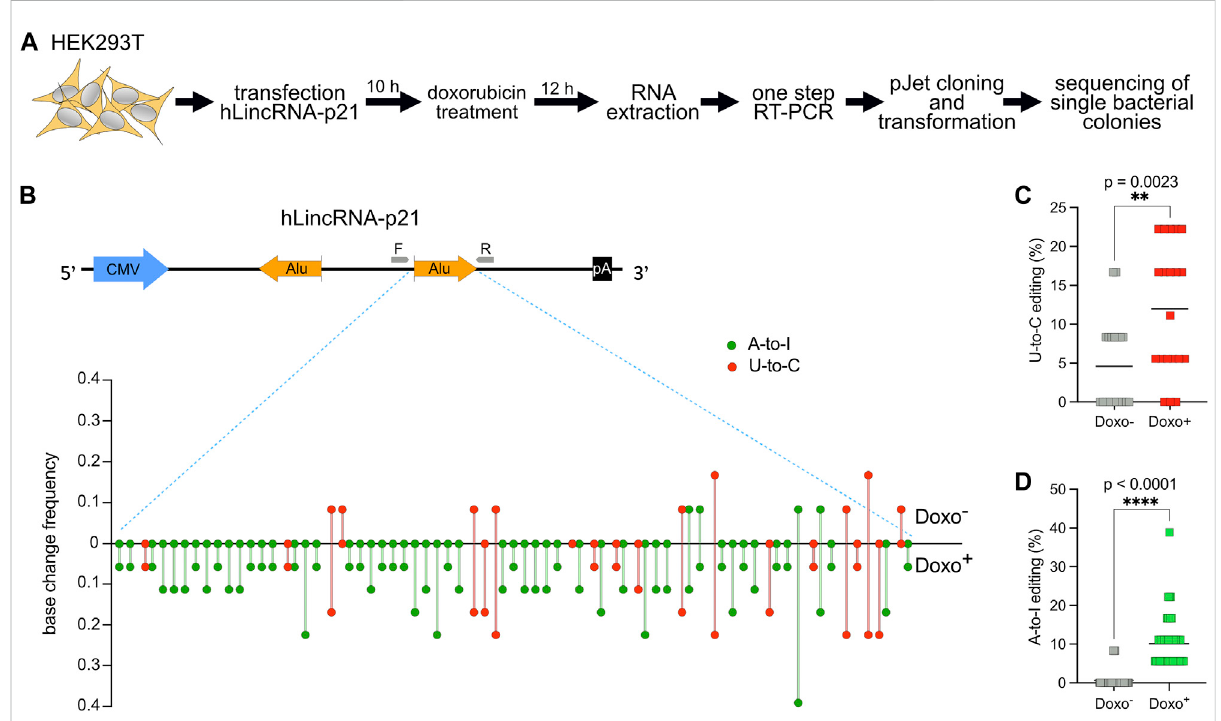
FIGURE 3 U-to-C base changesare present and dynamicalso inthelong intergenic non-coding RNA hLincRNA-p21 . (A) Flowchartoftheexperiment. (B) Upper: schematic representing the plasmid used for overexpression of hLincRNA-p21 . This long non-coding RNA contains two inverted Alu elements(bigorangearrows).PrimersusedforcDNAsynthesisandPCRampli fi cationarerepresentedassmallgreyarrows.Lower:Quanti fi cationof base changes within hLincRNA-p21 sense Alu element with and without doxorubicin (doxo) treatment based on sequences from bacterial colonies (Supplementary Figure S3). U-to-Cs and A-to-Is are shown in red and green, respectively. (C,D) Dot plots showing the increase of both U-to-Cs and A-to-Is upon doxorubicin treatment. Each dot = one single site; line = mean. A two-tailed unpaired t -test was used to compare the differences (** p < 0.01; **** p <